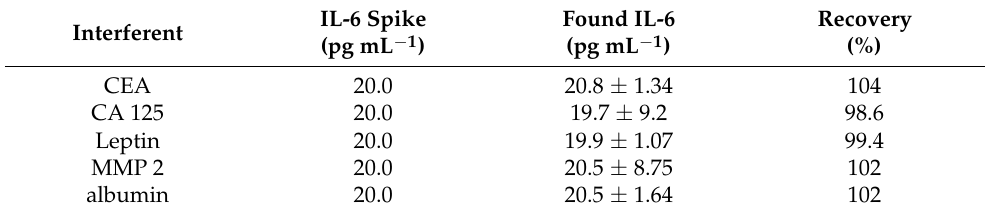
Table 2. Influence of excess of human albumin, leptin, CEA, CA-125 and metalloproteinase-2 (1000:1) on the results of determination of IL-6 concentration by the biosensor with the inhibitor as the receptor (biosensor (i)).